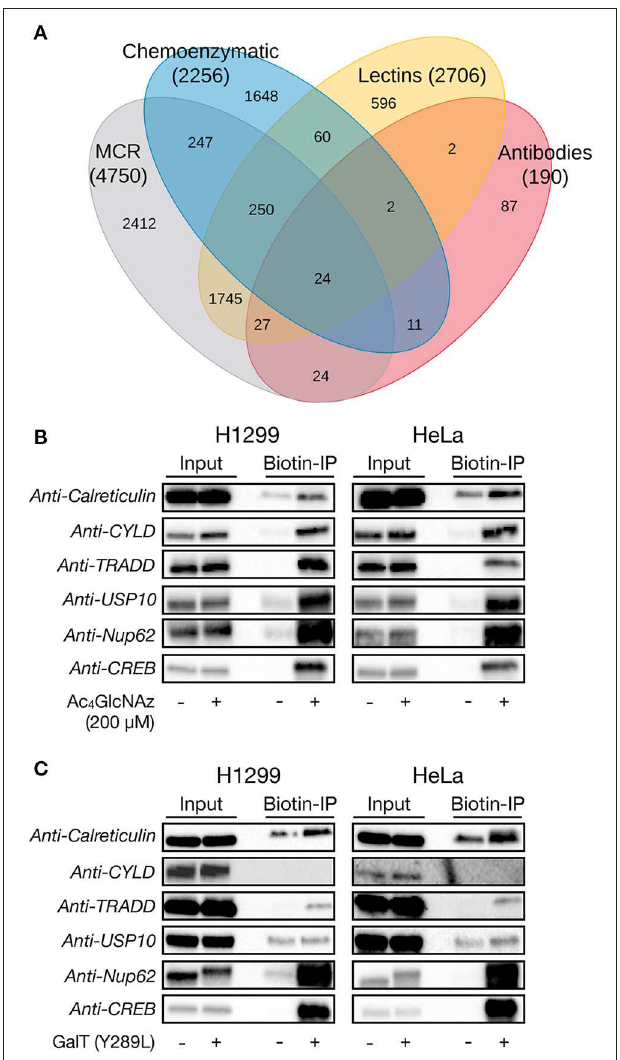
FIGURE 6 | Per- O -acetylated MCRs are imperfect but reasonable tools for the identification of potentially O-GlcNAcylated proteins. (A) Venn diagram showing the overlap between proteins that have been identified as being potentially O-GlcNAcylated by different enrichment methods. (B) H1299 or HeLa cells were treated with the widely-used O-GlcNAc MCR Ac 4 GlcNAz (200 µ M) for 16h, followed by CuAAC with a cleavable biotin linker, enrichment, release, and analysis by Western blotting. (C) H1299 or HeLa lysates were subjected to chemoenzymatic labeling of endogenous O-GlcNAc modifications with the same cleavable biotin linker. Modified proteins were visualized by Western blotting after enrichment and